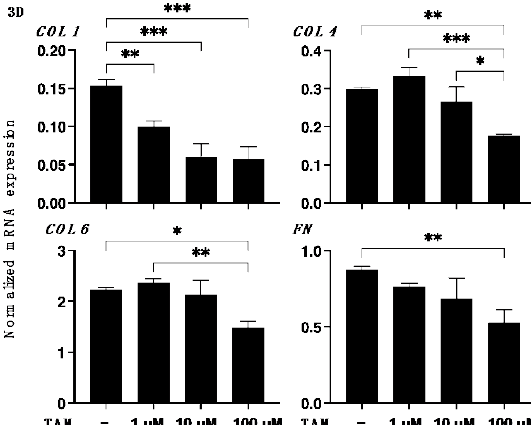
Figure 5. Effects of different concentrations of tamsulosin (TAM) on mRNA expression of ECMs in 3D spheroids of ARPE 19 cells. 3D ARPE 19 spheroids at Day 5 in the absence or presence of 1 μM, 10 μM or 100 μM tamsulosin (TAM) were subjected to qPCR analysis to estimate their mRNA expression of ECM proteins including COL1 , COL4 , COL6 and FN were performed. All experiments were performed in duplicate using fresh preparations ( n = 10-15, each). Data are presented as arithmetic means ± standard error of the mean (SEM). * p < 0.05, ** p < 0.01, *** p < 0.005 (ANOVA followed by a Tukey’s multiple comparison test).